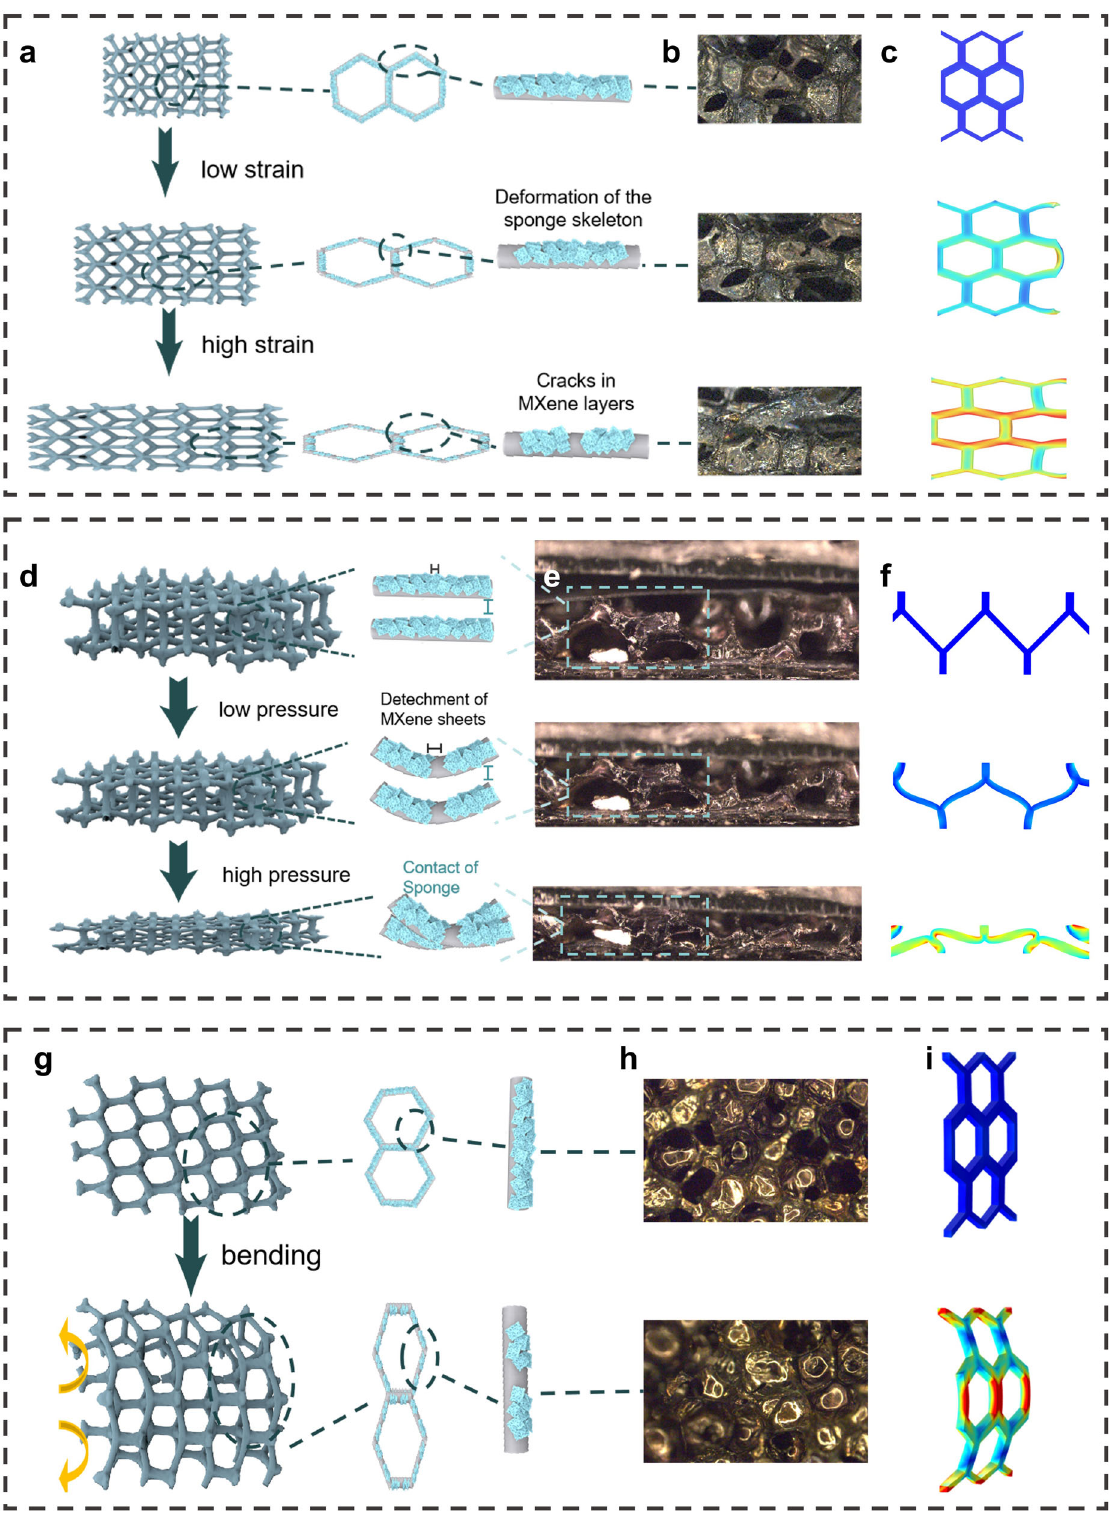
Fig. 5 Working mechanism of the PMPPF electrical device. a – c Stretch modes: a Schematic of sensor under low strain and high strain. b Optical microscope images of stretched sensor from surface topography. c Finite element simulates the stretching process. d – f Compression modes: d Schematic of sensor under low pressure and high pressure. e Optical microscope images of compression sensor from cross section topography. f Finite element simulates the compression process. g – i Bending modes: g Schematic of sensor under bending. h Optical microscope images of bending sensor from surface section topography. i Finite element simulates the bending